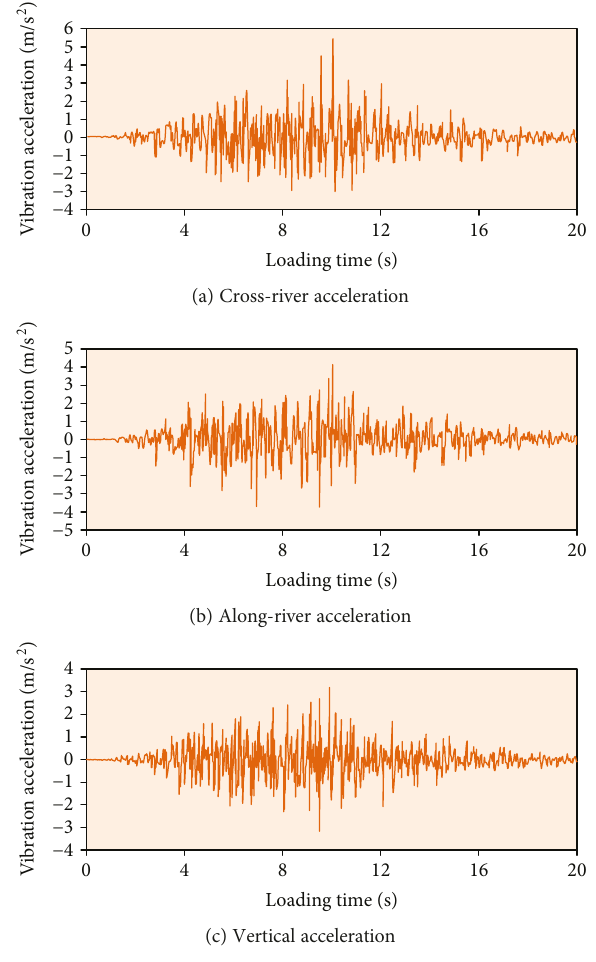
Figure 4: Time-interval acceleration of seismic waves in three directions of the arch